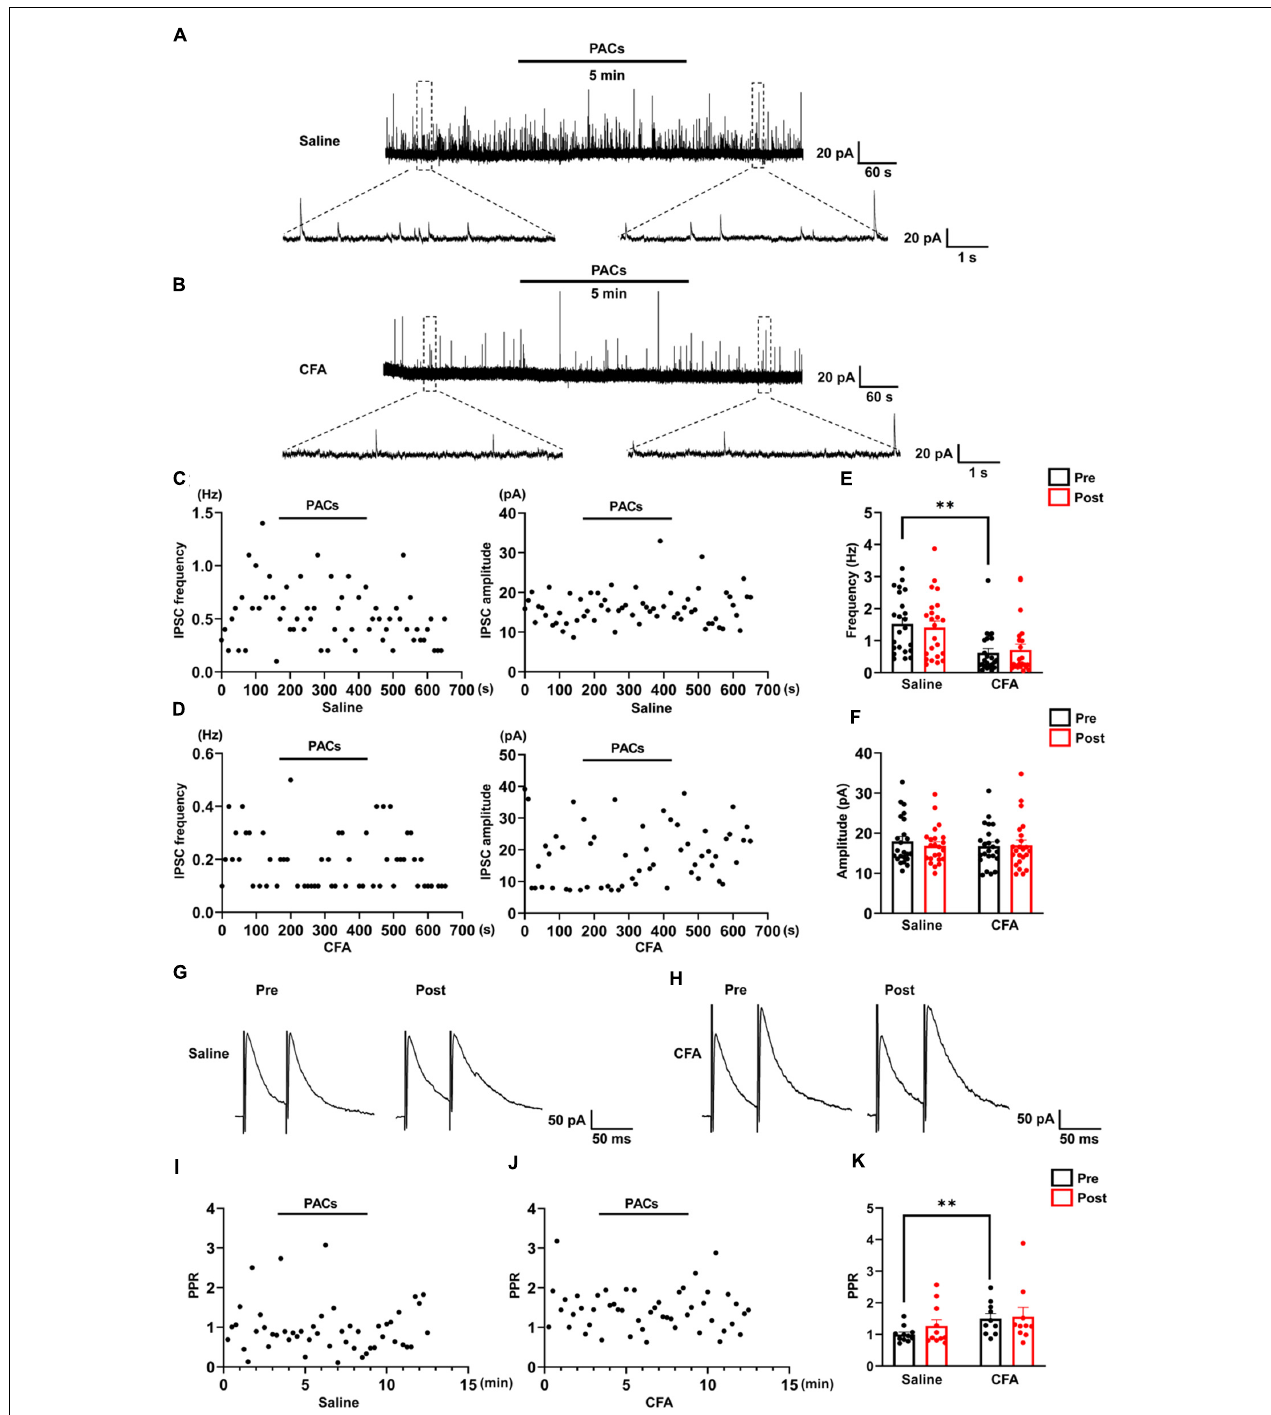
FIGURE 3 | The effect of proanthocyanidins on sIPSCs of PBN-projecting neurons in the spinal dorsal horn. Representative electrophysiological samples (A) and scatter plots (C) showing sIPSCs with bath application of proanthocyanidins (50 µ M) in the saline group. Representative electrophysiological samples (B) and scatter plots (D) showing sIPSCs with bath application of proanthocyanidins in the CFA group. Application of proanthocyanidins had no effect on the frequency (E) and amplitude (F) of sIPSCs in the CFA or saline group. Representative electrophysiological samples (G) and scatter plots (I) showing the PPR with bath application of proanthocyanidins in the saline group. Representative electrophysiological samples (H) and scatter plots (J) showing the PPR with bath application of proanthocyanidins in the CFA group. (K) Application of proanthocyanidins had no effect on the PPR in the CFA or saline group. ∗∗ P < 0.01. CFA, Complete Freund’s Adjuvant; PACs, proanthocyanidins; PPR, paired-pulse ratio.